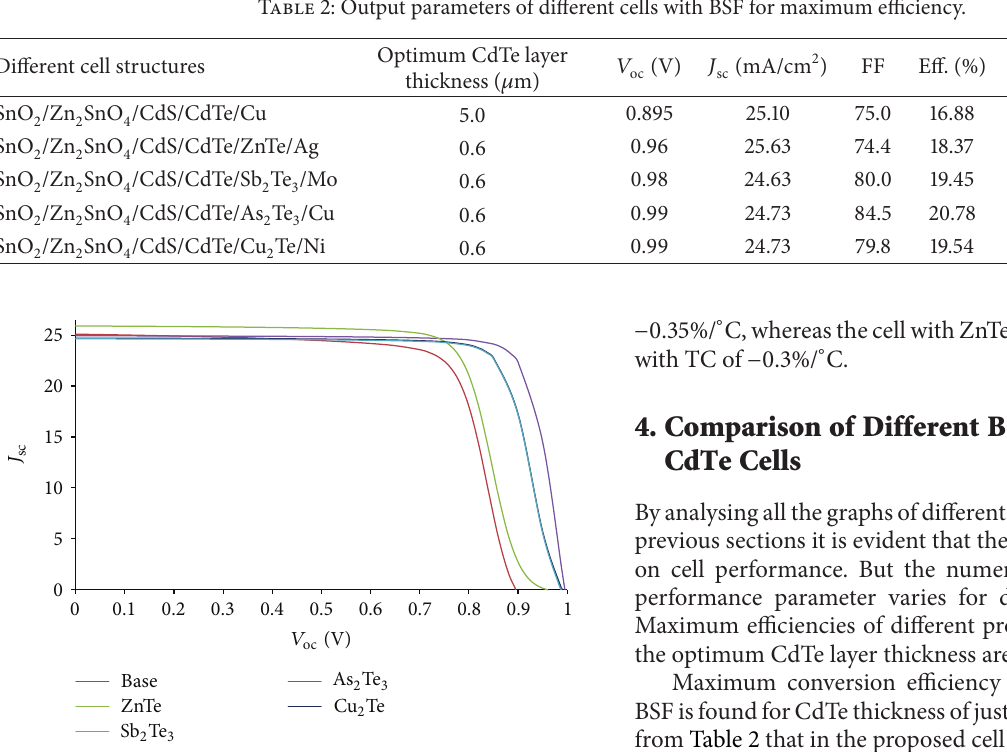
Figure 7: 𝐼 - 𝑉 curve of base cell and modified cell.